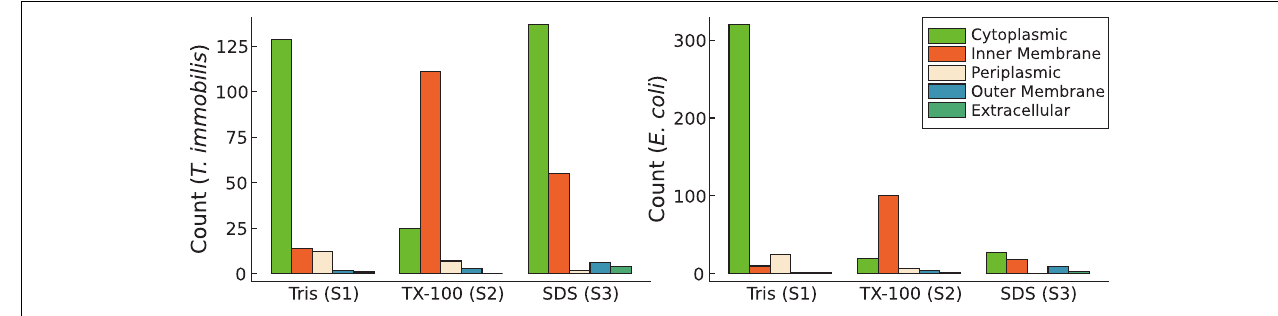
FIGURE 9 | Subcellular localization predictions for proteins exclusively identified in either Tris soluble [“Tris (S1)”], Tris/TX-100 soluble [“TX-100 (S2)”], or Tris/SDS soluble [“SDS (S3)”] fractions in T. immobilis and E. coli ; C: cytoplasmic; IM: inner membrane; P, periplasmic; OM, outer membrane; E, extracellular. Subcellular localization predictions were performed using PSORTb v3.0. In addition to the PSORTb v3.0 predictions, outer membrane proteins were predicted using